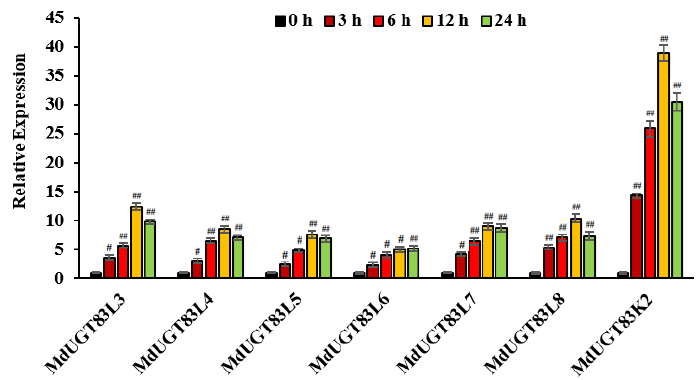
Figure 2. Expression of apple glycosyltransferase Group I family related genes induced by herbicide QPP. For the treatment of wild-type “Gala” seedlings (normal culture for 3 weeks), QPP synthesized was prepared in a solution with a final concentration of 10 µ mol/L. After 12 h, the materials were collected and stored at − 80 ◦ C for subsequent RNA extraction. Note: # p < 0.05, ## p < 0.01, n =